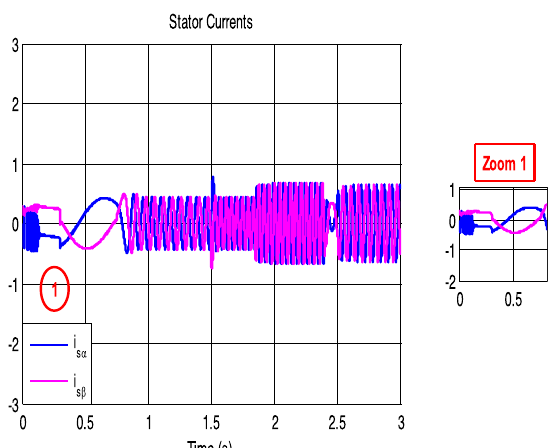
Fig. 17 PI-DTC-SPWM with three-level inverter stator current components